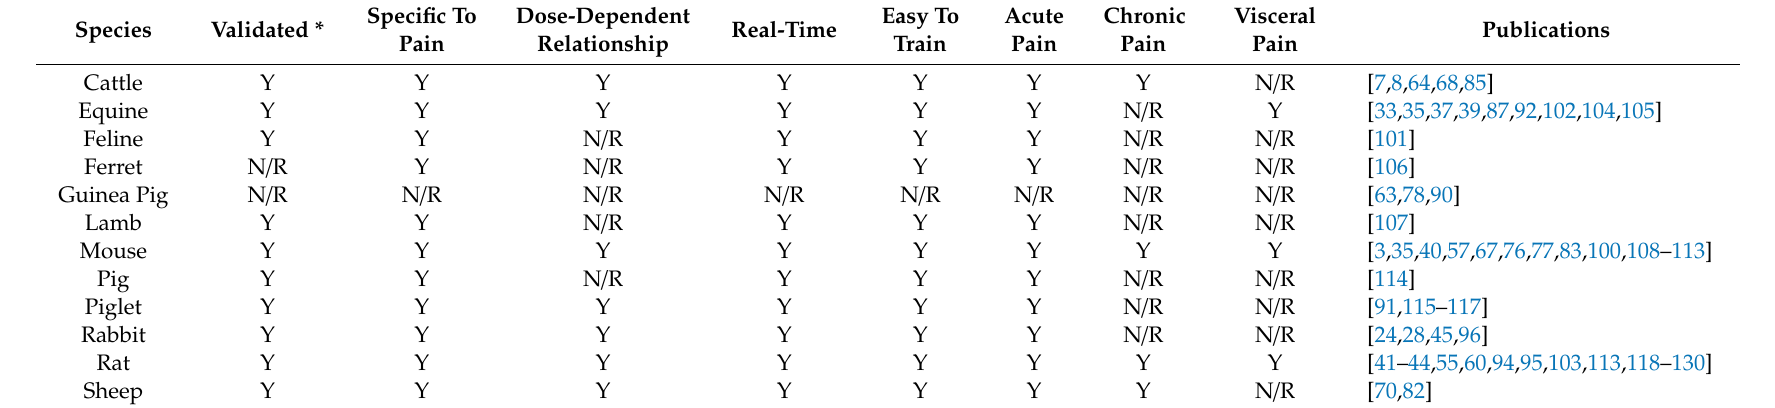
Table 2. Summary of species-specific available grimace